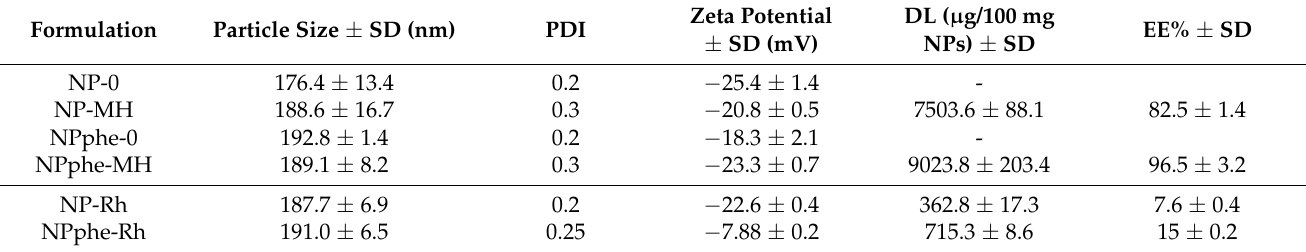
Table 2. Mean ( ± SD) particle size, zeta potential, drug loading (DL), and encapsulation efficiency (EE%) of the NPs formulations. Mean values of the polydispersity index